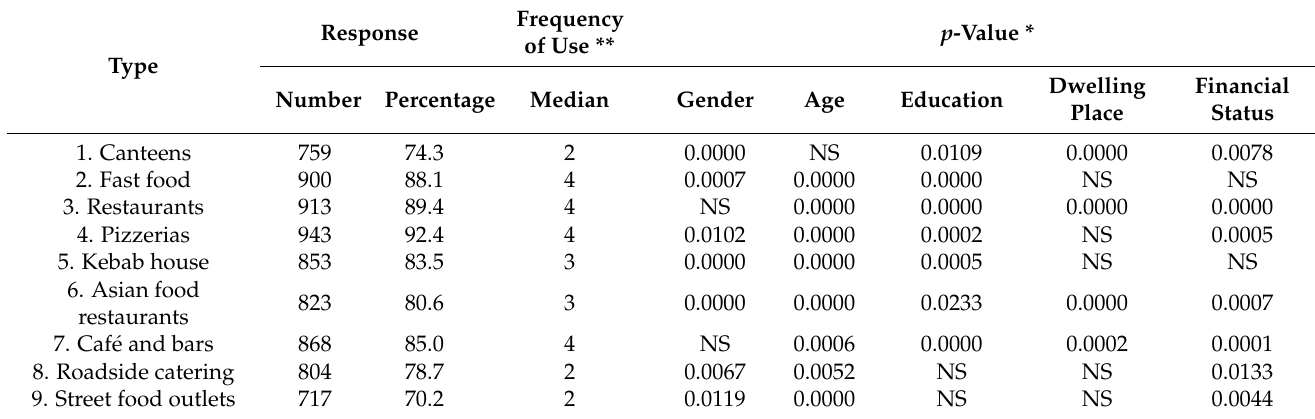
Table 2. Using catering establishments, frequency of use before pandemic